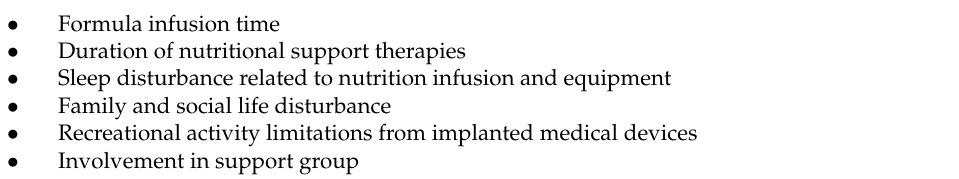
Table 6. Factors affecting the quality of life of patients on